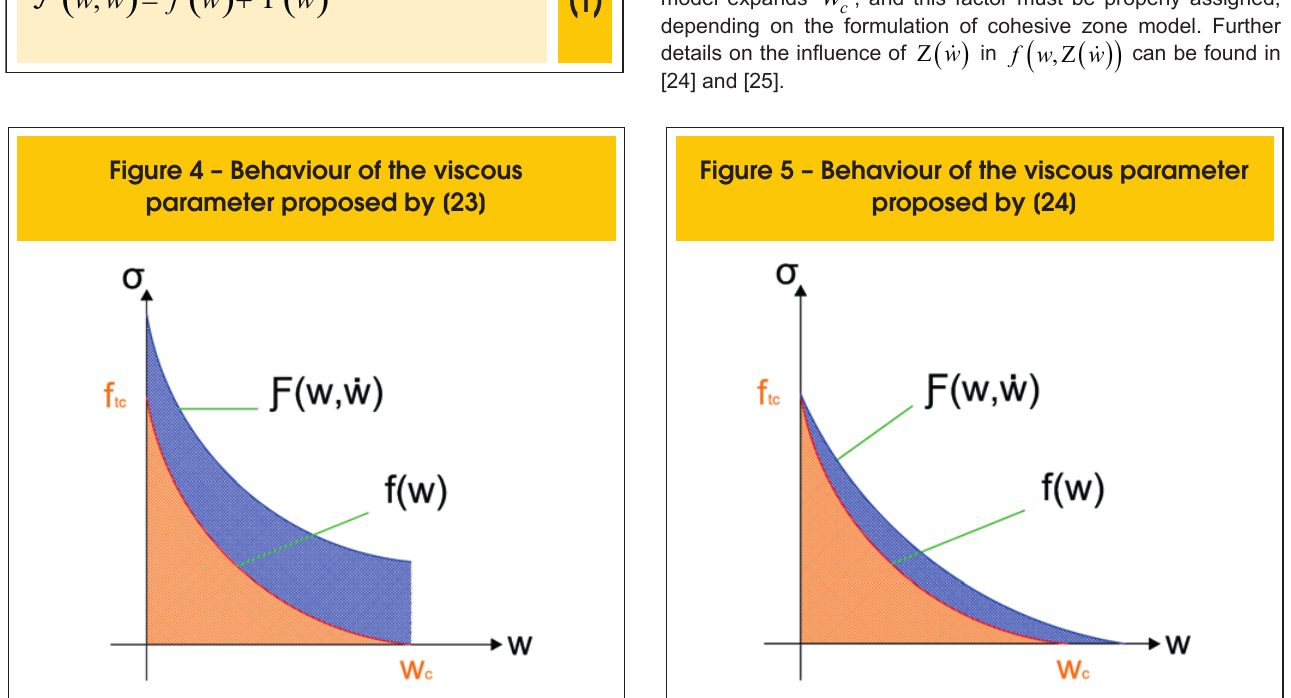
Figure 5 – Behaviour of the viscous parameter proposed by